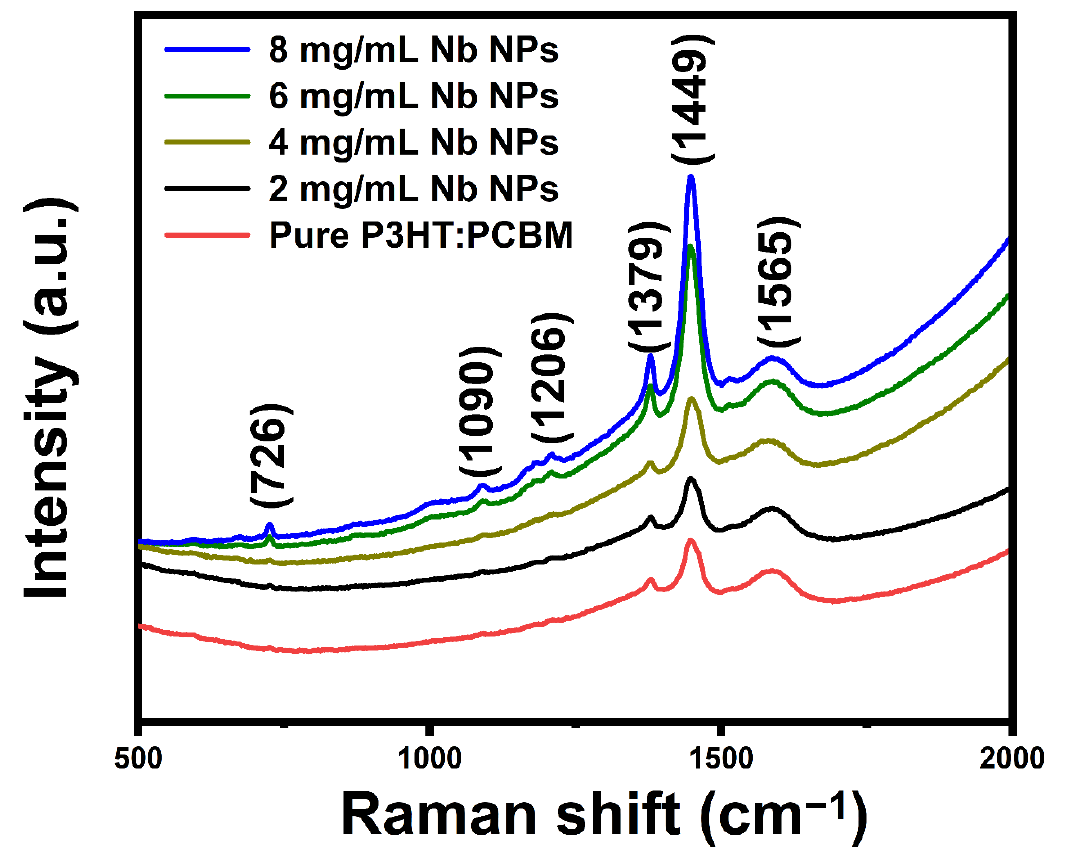
Figure 3. Raman spectra of pure P3HT:PCBM and P3HT:PCBM:Nb thin films synthesized with varying amounts of Nb nanoparticles.